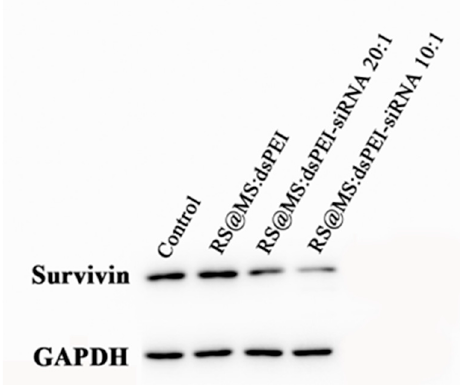
Figure 7. Western-blot assay. HeLa Cells were treated by RS@MS:dsPEI, RS@MS:dsPEI-siRNA with N/P ratios of 10:1 and 20:1, respectively.